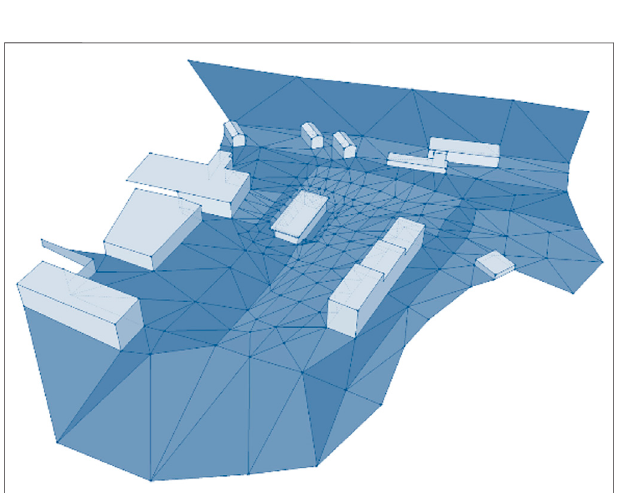
FIGURE 5 | Model for the acoustic de fi nitions. The three blue tonalities refer to the acoustic materials assigned to the mesh: (A) hard-buildings, re fl ective, and diffuse; (B) soft-grass and moderately absorptive; (C) hard- asphalt and re fl ective.